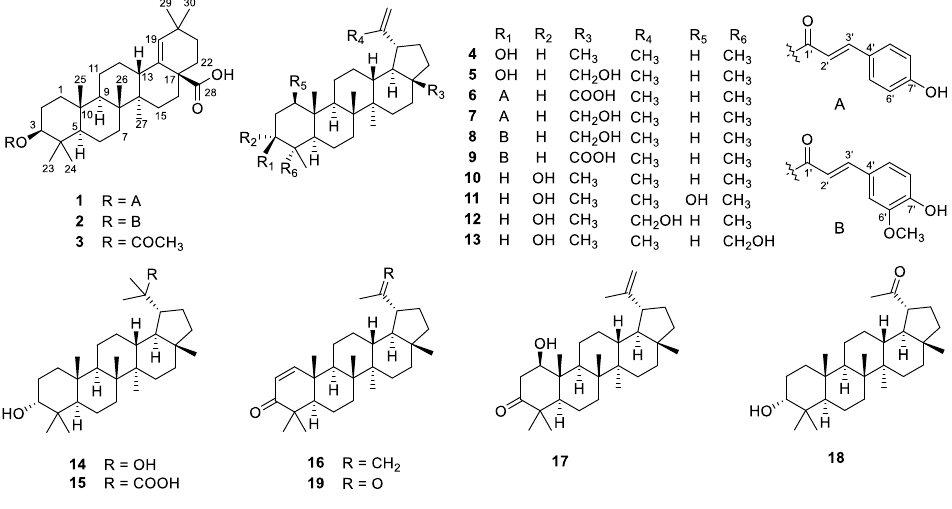
Figure 1. Structures of 1 − 19 . Compound 1 , white powder, possessed the molecular formula C 39 H 54 O 5 as deter- mined by the HRESIMS ion at m/z 625.3853 [M + Na] + (calcd. For C 39 H 54 O 5 Na + , 625.3863). The IR absorption bands revealed the presence of carbonyls (1690 and 1605 cm − 1 ). The 1 H NMR data (Table 1) exhibited signals indicative of seven methyl singlets [ δ s), 1.10 (3H, s), 1.04 (3H, s), 0.99 (6H, s), 0.97 (3H, s), and 0.82 (3H, s)], one trisubstituted double bond proton [ δ H 5.33 (1H, s)], a trans-coumaroyl moiety [ δ H 8.07 (1H, d, J = 15.9 Hz), 7.69 (2H, d, J = 8.2 Hz), 7.20 (2H, m), and 6.74 (1H, d, J = 15.9 Hz)] [18], an oxymethine proton [ δ H 4.90 (1H, dd, J = 11.6, 4.7 Hz)], along with a series of aliphatic multiples. The 13